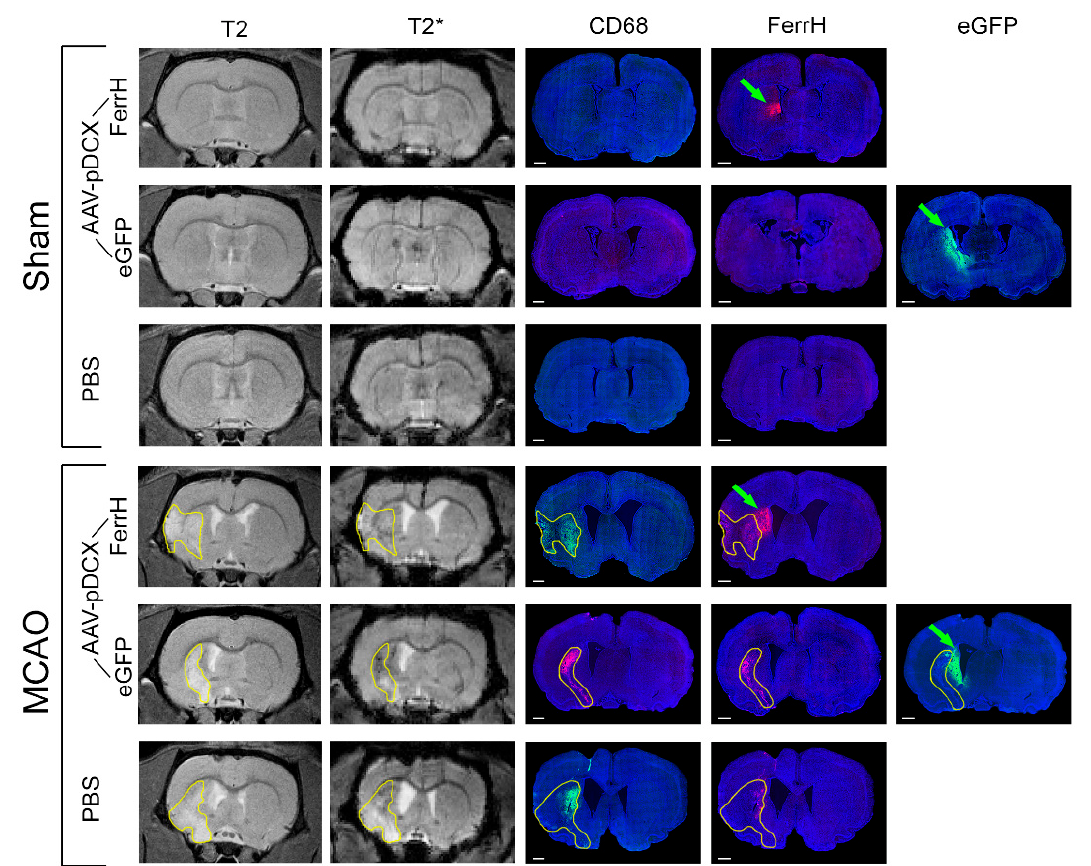
Figure 4. Representative T2- and T2*-weighted images in sham (top three rows) and MCAO (bottom three rows) animals are shown for day 28 after injection of viral vectors. Immunofluorescent staining were done for ferritin (FerrH) and activated microglia/macrophages (CD68). eGFP signal was read at the fluorescent microscope with a wavelength of 488 nm. Areas of ischemic lesion were delineated on T2-weighted and propagated to T2*-weighted and to the histological images (bottom three rows). Green arrows point to areas of the transgene expression near the SVZ outside of the ischemic lesion . Abbreviations: MCAO, middle-cerebral-artery occlusion; AAV, adeno-associated viral backbone; pDCX, doublecortin promoter; FerrH, ferritin heavy chain; eGFP, enhanced green fluorescent protein; PBS, phosphate-buffered saline; SVZ, subventricular zone.